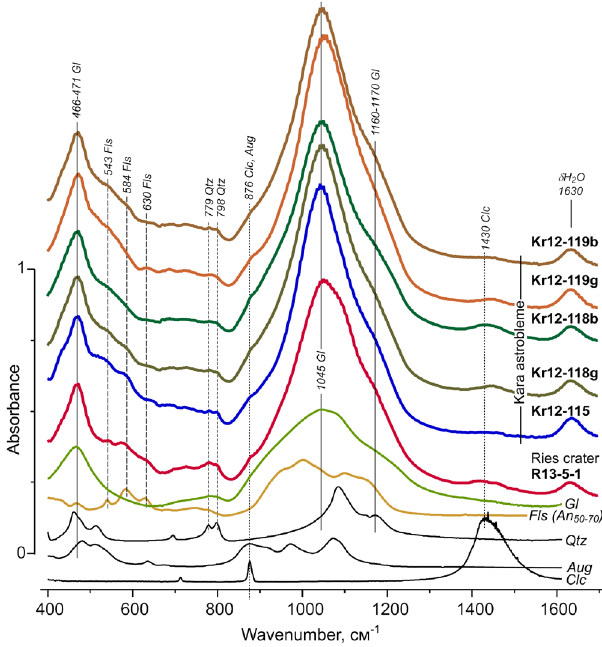
Figure 6. FTIR absorption spectra of impact glasses and standard samples: Fls – plagioclase (labrador An 50–70 ), Gl – aluminosilicate glass, Qtz – quartz, Aug – pyroxene (augite), Clc–